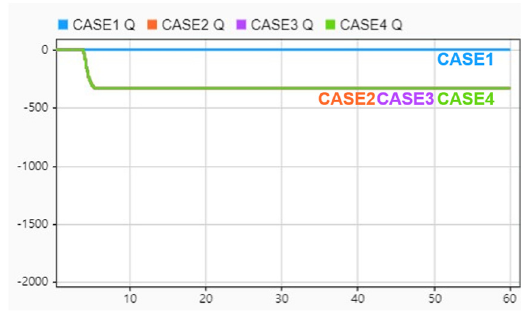
Figure 20. Reactive power output of the G2 inverter.